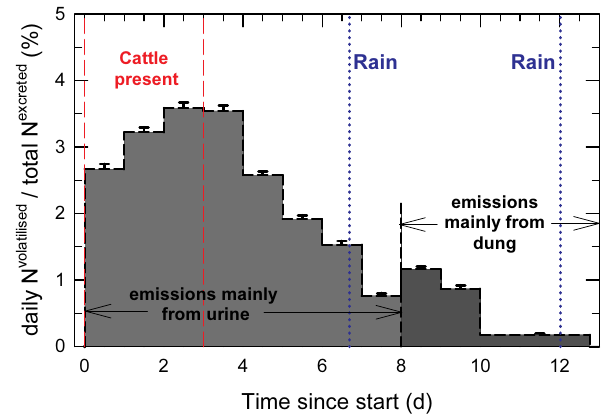
Fig. 5. Day-to-day evolution of N loss fraction due to volatilisation, relative to the amount of N excreted by 12 cattle over the first 3 days. The vertical dashed line at 8d marks when N loss rates cease to be dominated by volatilisation from urine, and emissions from dung probably begin to constitute the major fraction. The times of the two rain events with more than 1mm yield are marked by dotted